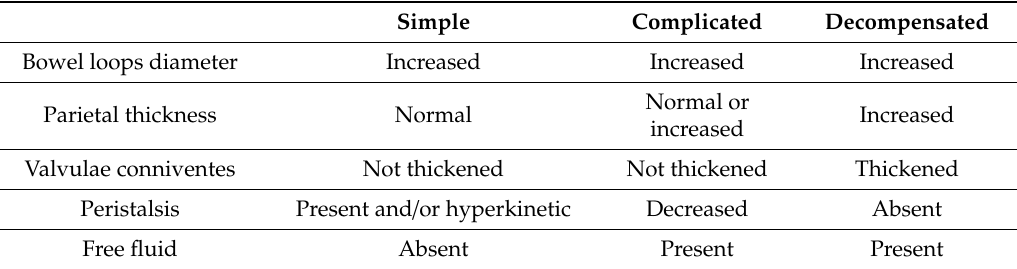
Figure 2. A 56-year-old male patient with virgin abdomen with compensated ileus. ( a ) Ultrasound long axis evaluation of a fluid-filled dilated small bowel loop, parietal was not thickened, free fluid was detected (*), peristalsis was ineffective with “back and forth” movements and defined decreased. ( b ) CT examination with IV contrast and coronal reconstruction. Small bowel fluid filled dilated loops were detected, and meso stranding and free fluid between bowel loops were also present. A focal point of stricture was evident (white arrow). At surgery, after release of adhesion, the bowel loop pinks up, peristalsis recovered and resection was avoided. Table 1. Ultrasound criteria for SBO